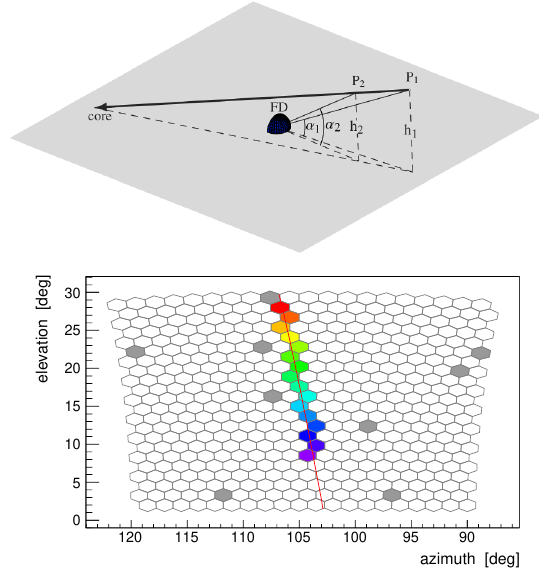
Figure 2. Geometry of a downward-going EAS with an impact point behind the field of view of an FD telescope (top panel). An image of such a shower moves in the field of view from bottom (magenta - former) to up (red - later) as marked by colours of triggered pixels (bottom panel). Gray pixels correspond to ran- dom triggers. The red line represents a projection of the shower axis.